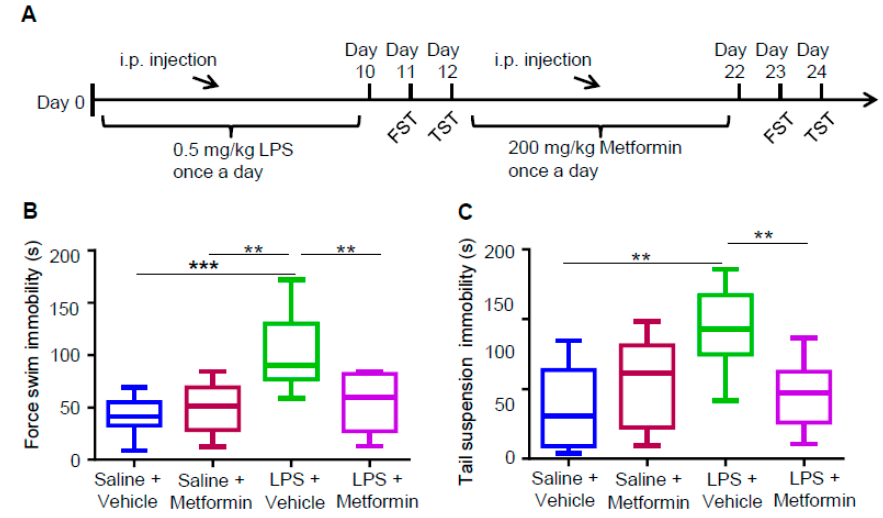
Figure 3. Metformin ameliorates LPS-induced depressive-like behaviors. ( A ) Schematic illustration of the experimental procedure for drug administrations and behavioral tests for depressive-like behaviors in mice. C57BL / 6 male mice at age of 6–7 weeks were i.p. injected with 0.5 mg / kg LPS or an equal volume of saline daily for 10 days. After selection through TST and FST, the mice exhibited depressive-like behaviors were i.p. injected with 200 mg / kg metformin or an equal volume of its vehicle for another 10 days. Then FST and TST were conducted at 24 and 48 h after the metformin treatment. ( B , C ) Increased immobility time in FST and TST induced by LPS was reduced by metformin treatment. Quantification of the immobility time (s) in 4 min for each group mice in FST ( B ) and TST ( C ) (n = 8–9 mice for each group; one-way ANOVA, ** p < 0.005, *** p < 0.001).